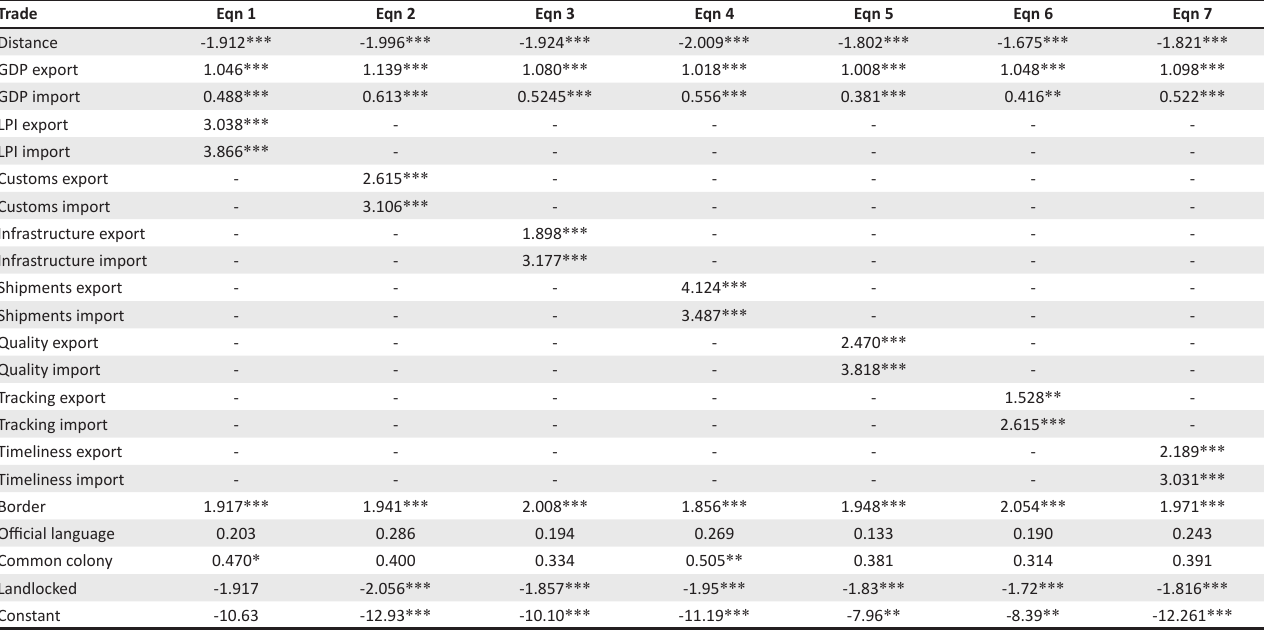
TABLE 3: Effect of Logistics Performance Index on intra-regional trade of Africa.